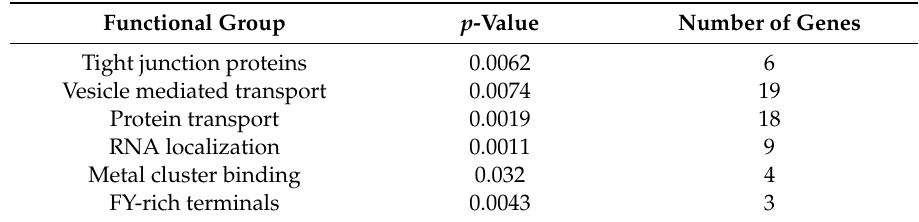
Table 1. Functional grouping analysis of microarray data using Database for Annotation Visualization and Integrated Discovery (DAVID).